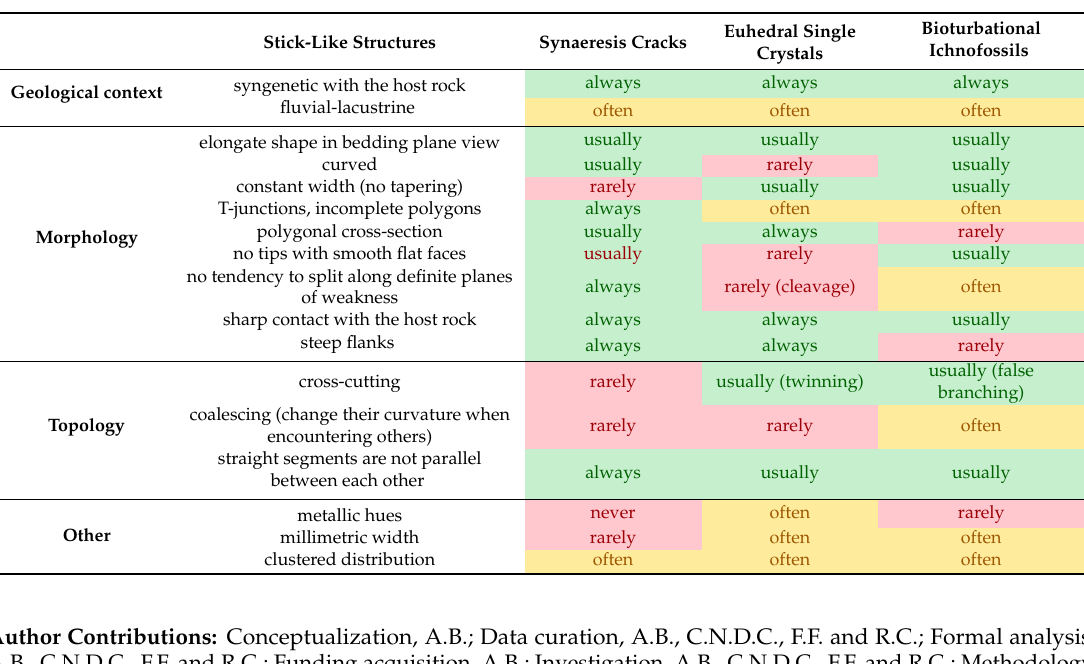
Table 1. Characteristics of the stick-like structures and their occurrence in their closest morphological analogues. Five occurrence classes are used (from the most frequent to the less frequent: always, usually, often, rarely, never). Color scale reflects frequency of